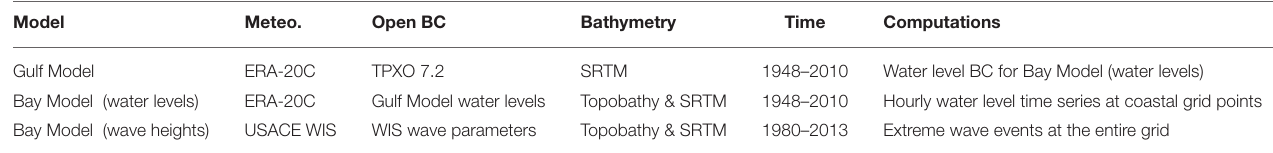
TABLE 2 | Overview: set up numerical models, used input, boundary conditions (BC), and conducted computations.